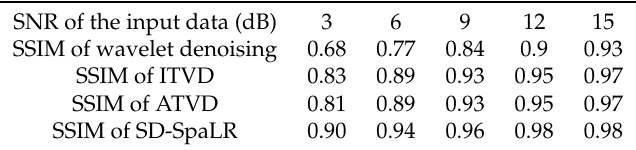
Table 2. Variation of structural similarity (SSIM) with the SNR of the input seismic